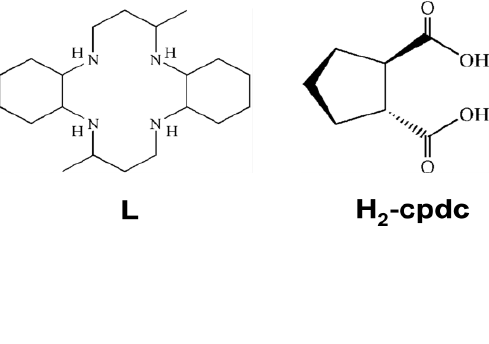
Figure 1. Selected bond distances and angles are listed in Table 1. The skeleton of the macrocyclic unit in 1 adopts the classical trans- III ( R , R , S , S ) conformation with two chair-form six-membered and two gauche-form five-membered chelate rings. The central nickel atom is located on an inversion